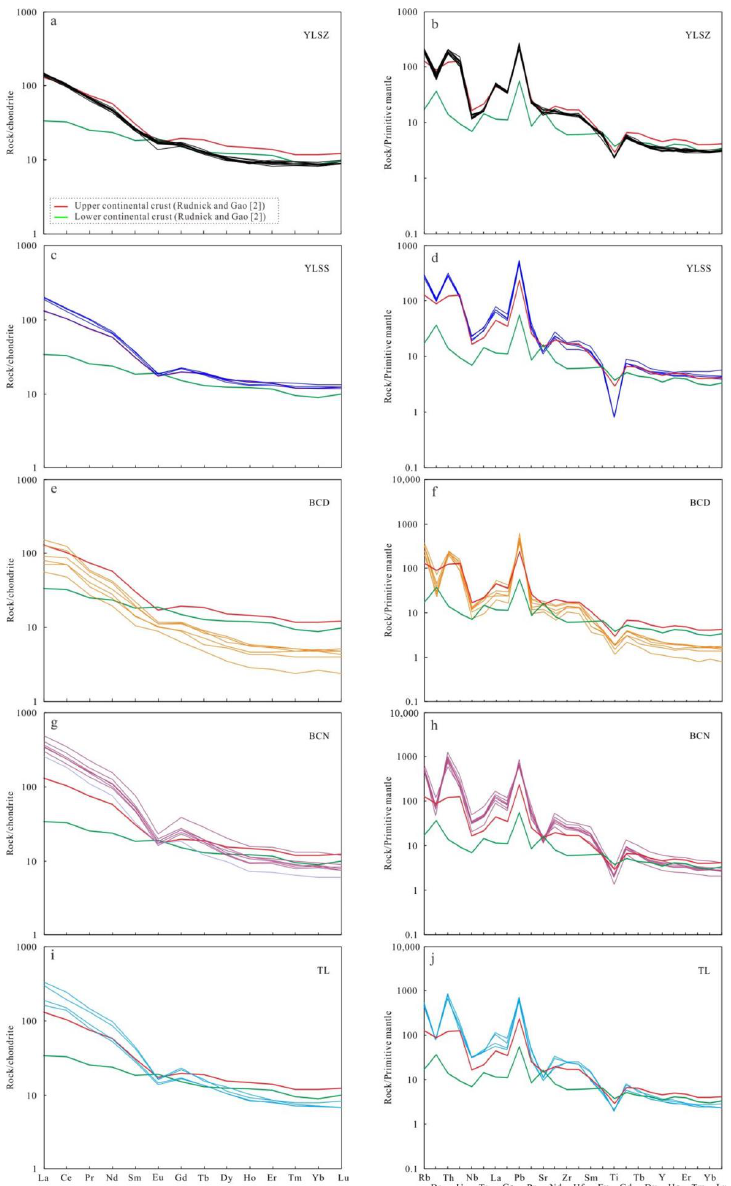
1 Figure 7. Chondrite-normalized REE (left) and primitive mantle-normalized trace element (right) patterns for the Yilashan and Amdo granitoids in the Nagqu area. The chondrite and primitive mantle normalization data are from [79]. Data for Upper and Lower continental crust are from [2]. ( a ):YLSZ; ( b ):YLSZ; ( c ): YLSS; ( d ): YLSS; ( e ):BCD; ( f ):BCD; ( g ): BCN; ( h ): BCN; ( i ): TL; ( j ):